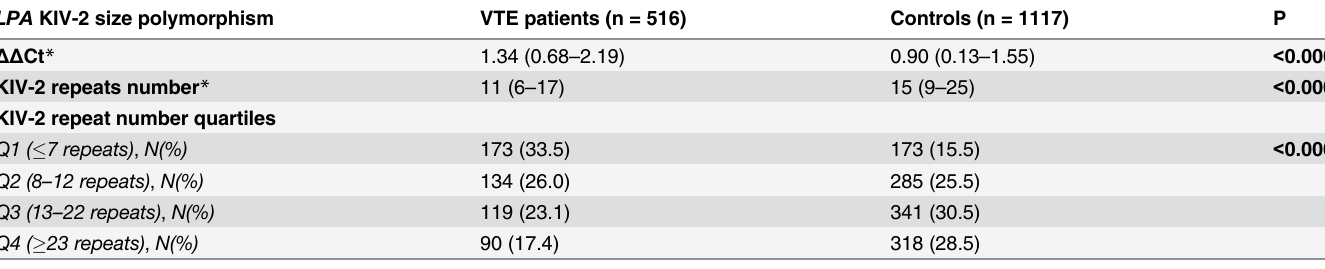
Table 5. LPA KIV-2 repeats in VTE patients.